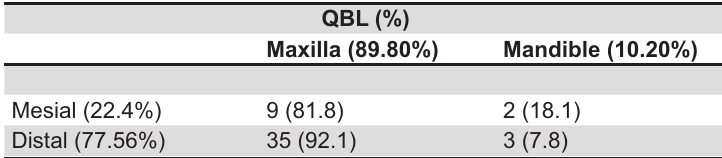
Prevalence of alveolar bone loss in healthy children treated at private pediatric dentistry Table 4- Number and distribution of Questionable Bone Loss (QBL) sites